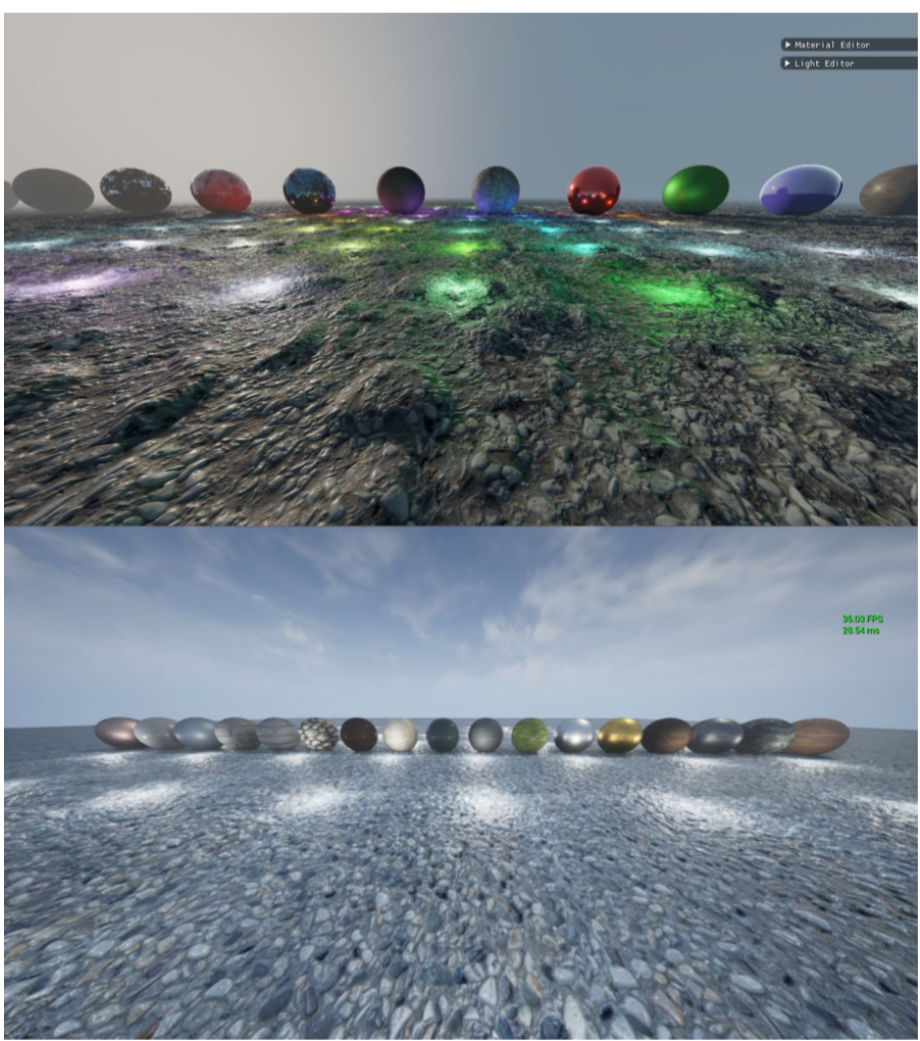
Figure 6. Real-time shadows in the raymarching renderer ( top ) and UE4 ( bottom